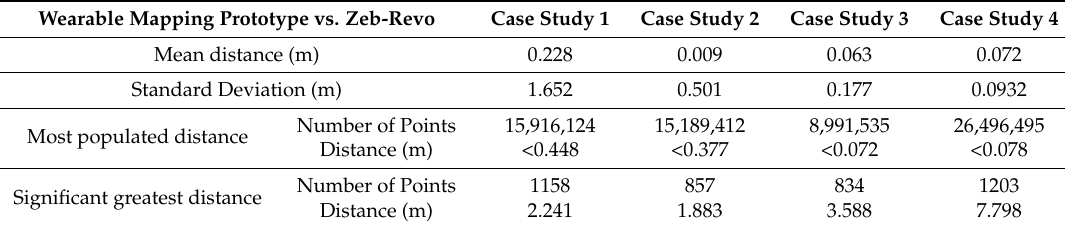
Table 12. Point-cloud to point-cloud distance between the Wearable Mapping Prototype and the Zeb-Revo, for the four case